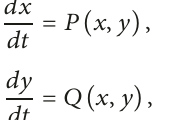
Therefore, if |𝜇| < 1 holds, the semitrivial periodic solution (0, 𝜂(𝑡)) is orbitally asymptotically